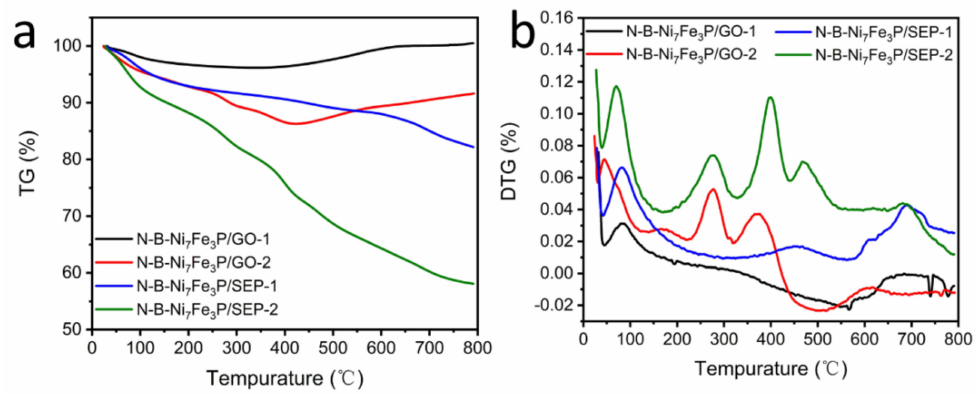
Figure 7. TG ( a ) and TGA ( b ) curves of N-B-Ni 7 Fe 3 P/SEP and N-B-Ni 7 Fe 3